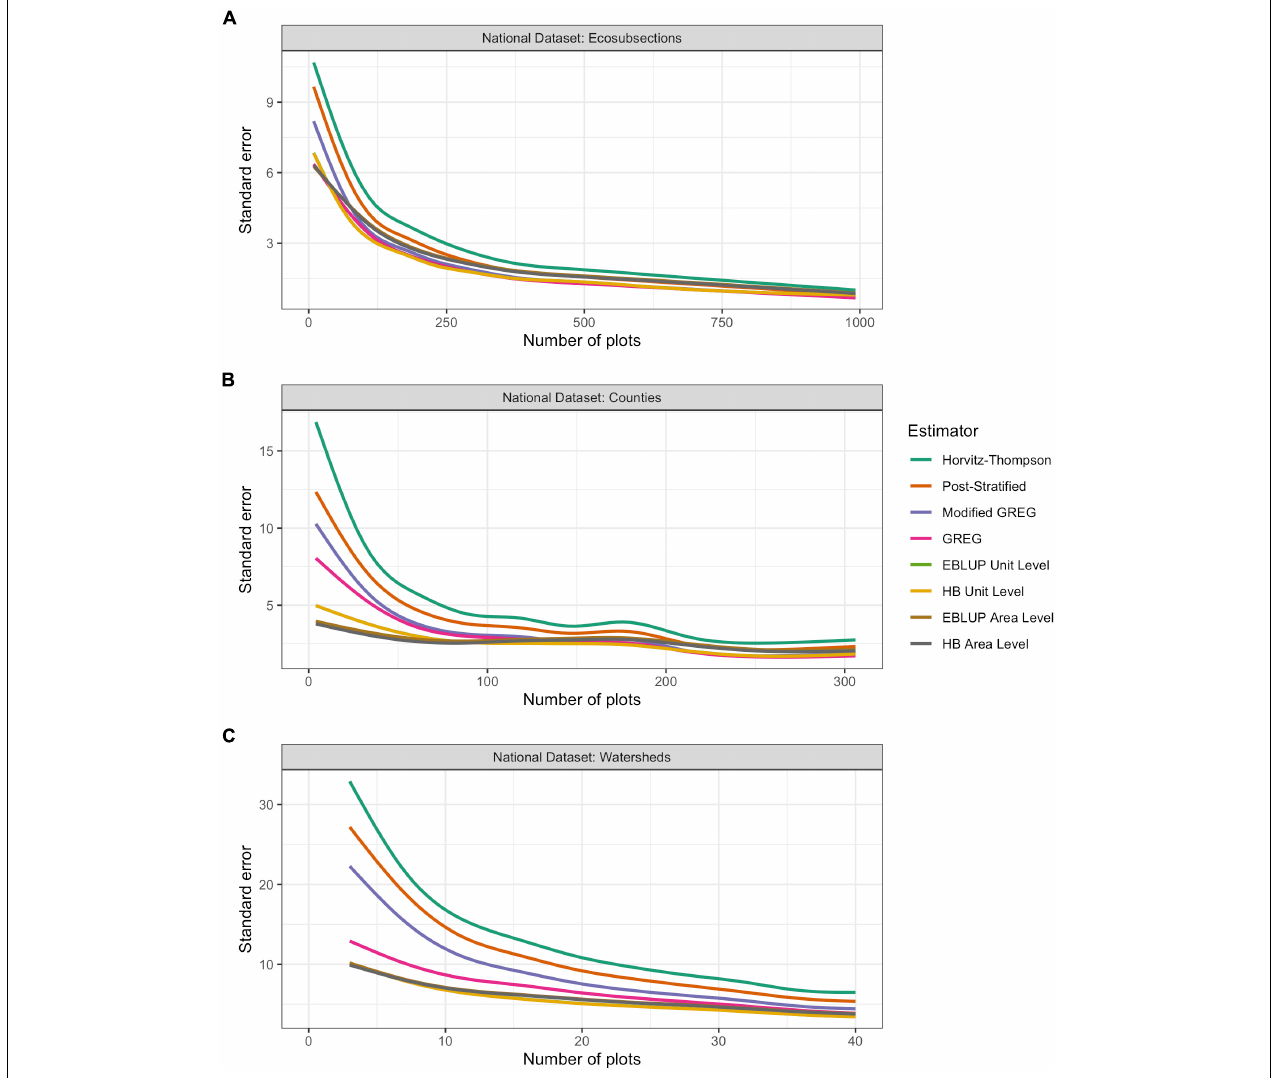
FIGURE 8 | Smoothed standard errors by number of plots for all estimates of basal area obtained over (A) ecosubsections, (B) counties, and (C) watersheds. The lines used to represent the data were created with a generalized additive model using smoothing splines with a cubic spline basis. The y -axis represents the standard error of each estimator and the x -axis represents the number of plots within the domain of interest. For each plot, we trimmed the number of plots to the 0.95 quantile in order to avoid high leverage points in the smoothing algorithm. This 0.95 quantile point was found to be 991 for ecosubsections, 277 for counties, and 40 for watersheds. These plots were created only for regions where no estimators produced NA